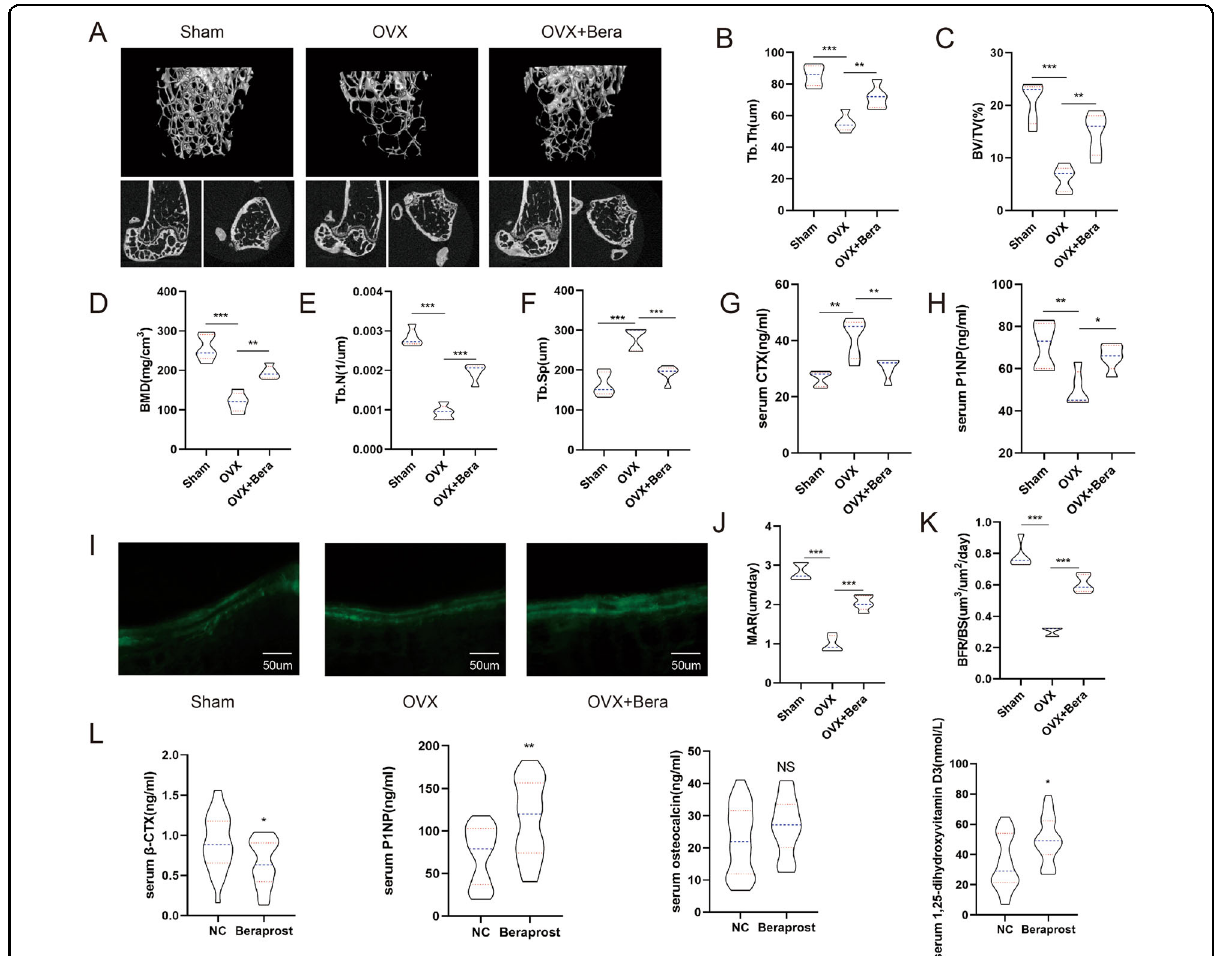
Fig. 1 Beraprost treatment prevents bone loss induced by ovariectomy. A Representative images of micro-CT reconstruction of distal femurs. B – F Quantitative analyses of micro-CT of distal femurs. Results are shown as mean ± standard deviation (SD); n = 5; * P < 0.05, ** P < 0.01, and *** P < 0.001 by analysis of variance (ANOVA) with Tukey ’ s post-hoc test. BMD bone mineral density (mg/cm 3 ); Tb.N trabecular number (1/µm), Tb.Sp trabecular separation (µm), Tb.Th trabecular thickness (µm), BV/TV bone volume (%). G , H Serum concentration of β -CTX and P1NP. Results are shown as mean ± SD; n = 5; ** P < 0.01, *** P < 0.001 by ANOVA with Tukey ’ s post-hoc test. I Representative images of calcein double-labeled distal femurs. Scale bars = 50 μ m. J , K Quanti fi cation of mineral apposition rate (MAR, µm/day), and bone-formation rate over bone surface (BFR/BS, µm 3 /µm 2 /day). Results are shown as mean ± SD; n = 5; *** P < 0.001 by ANOVA with Tukey ’ s post-hoc test. L Concentrations of β -CTX, P1NP, osteocalcin, and